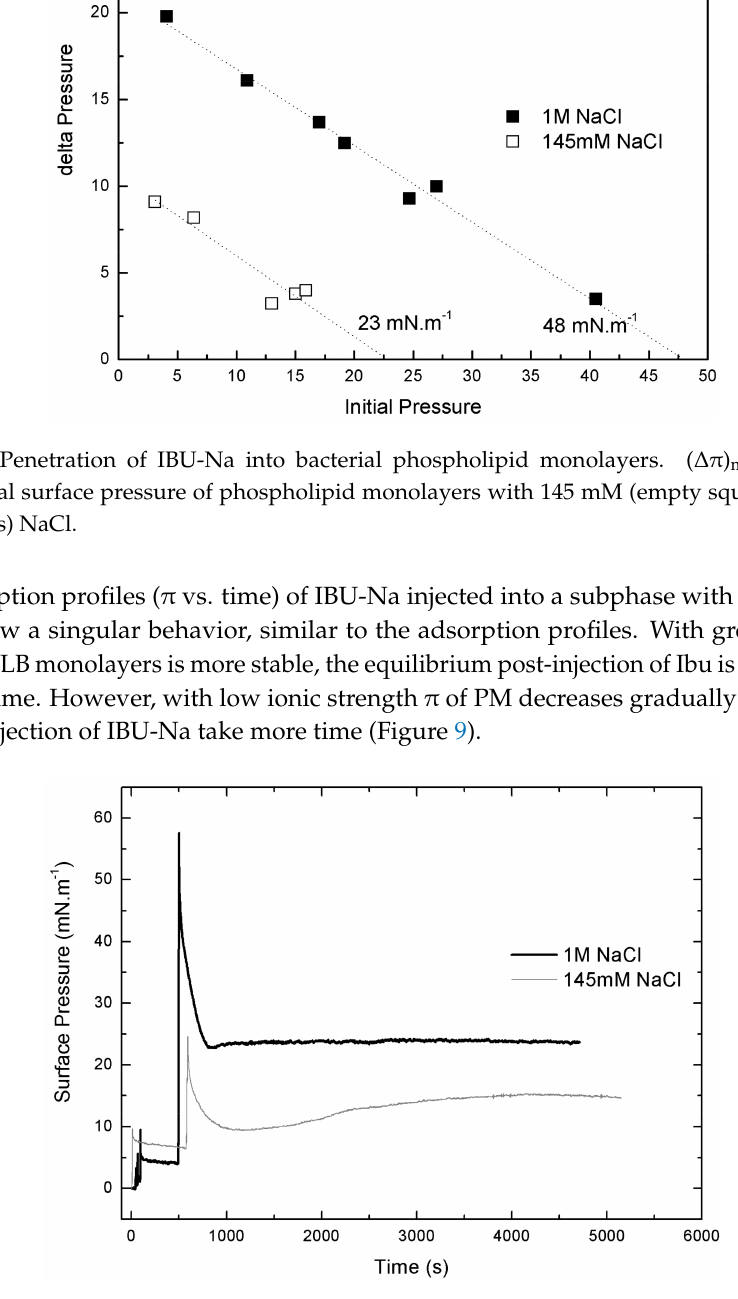
Figure 9. Effect of salt concentration on the penetration of IBU-Na. Surface pressure versus time of IBU-Na injected into subphases of bacterial phospholipids with 145 mM and 1 M